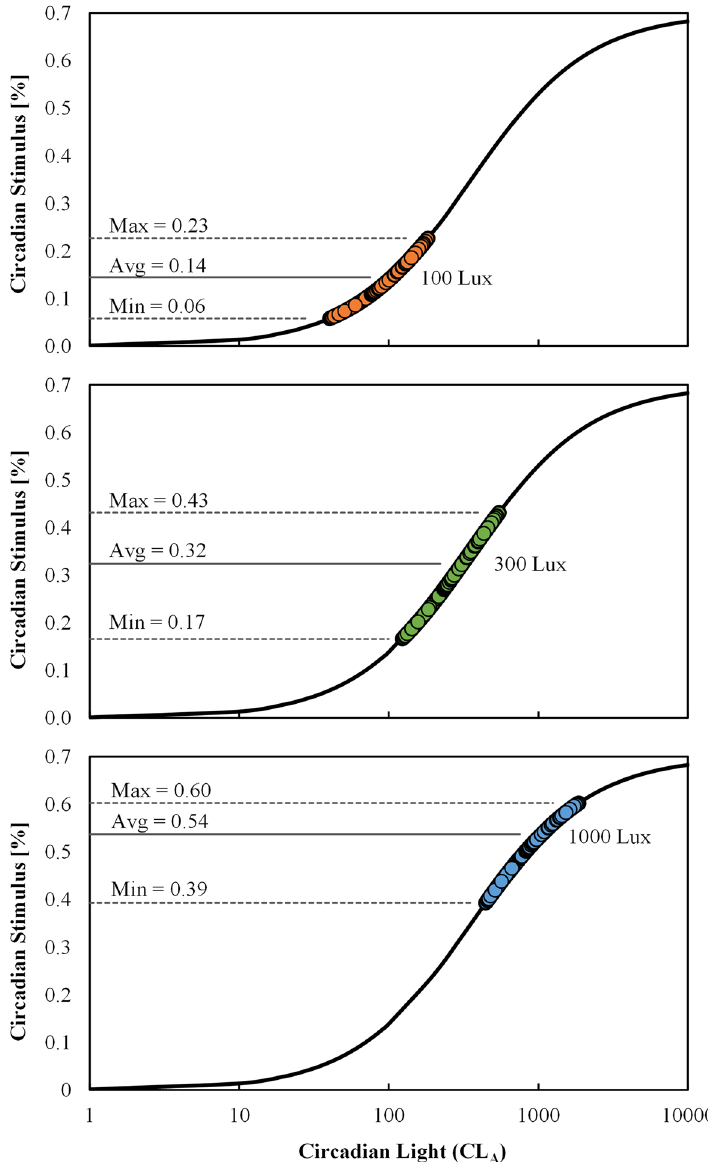
Figure 7. The range of Circadian Stimulus (CS) values as a function of Circadian light (CL A ) for 100 lx (top), 300 lx (middle), and 1000 lx (bottom). At any fixed photopic illuminance, a substantial range of CS values can be achieved due to the choice of spectrum alone. The largest range occurs near 300 lx which falls near the inflect point of the CS sigmoid curve. Values are not sub-divided by